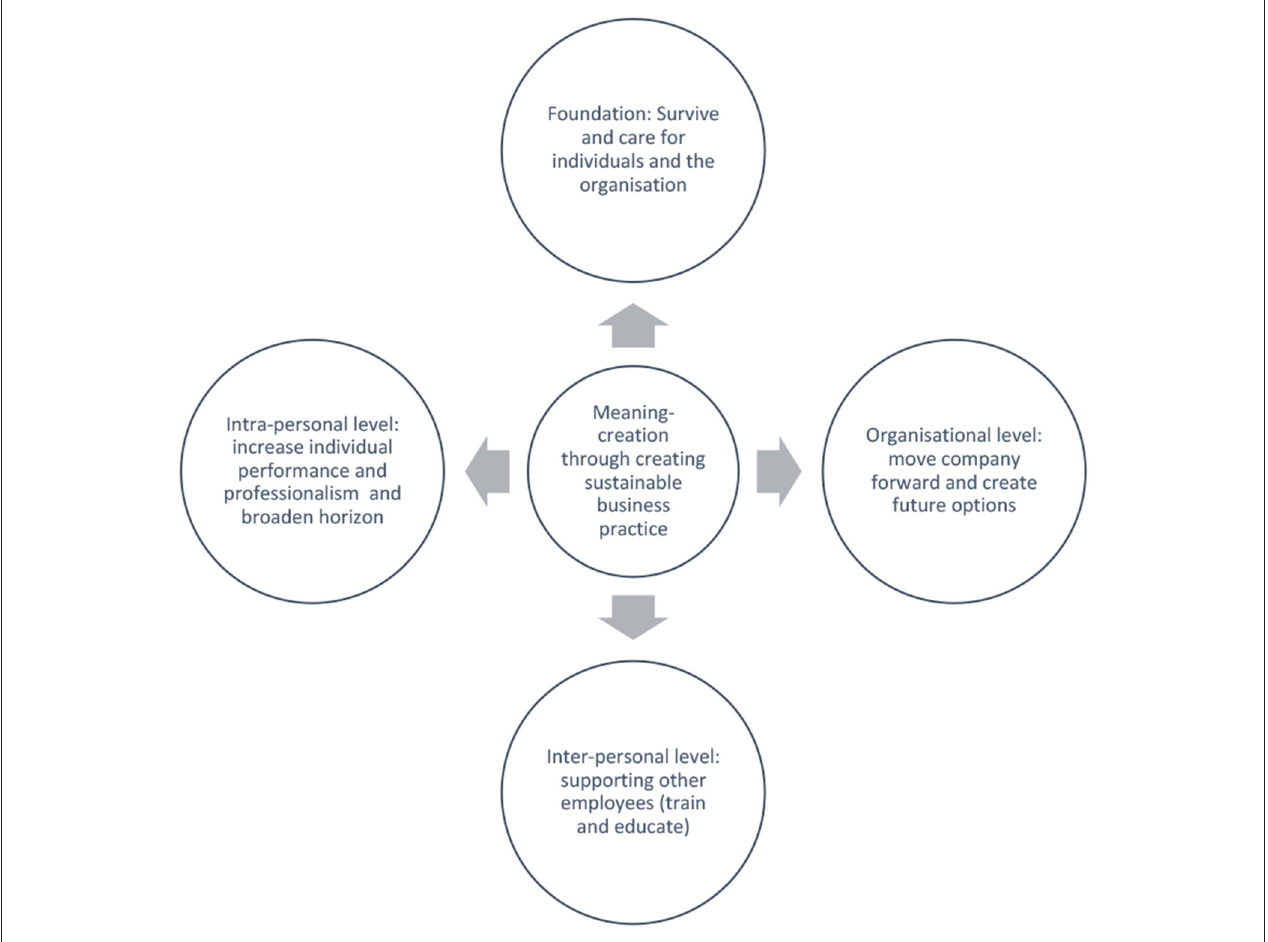
FIGURE 3 | Meaning-making in sustainable I4.0 business